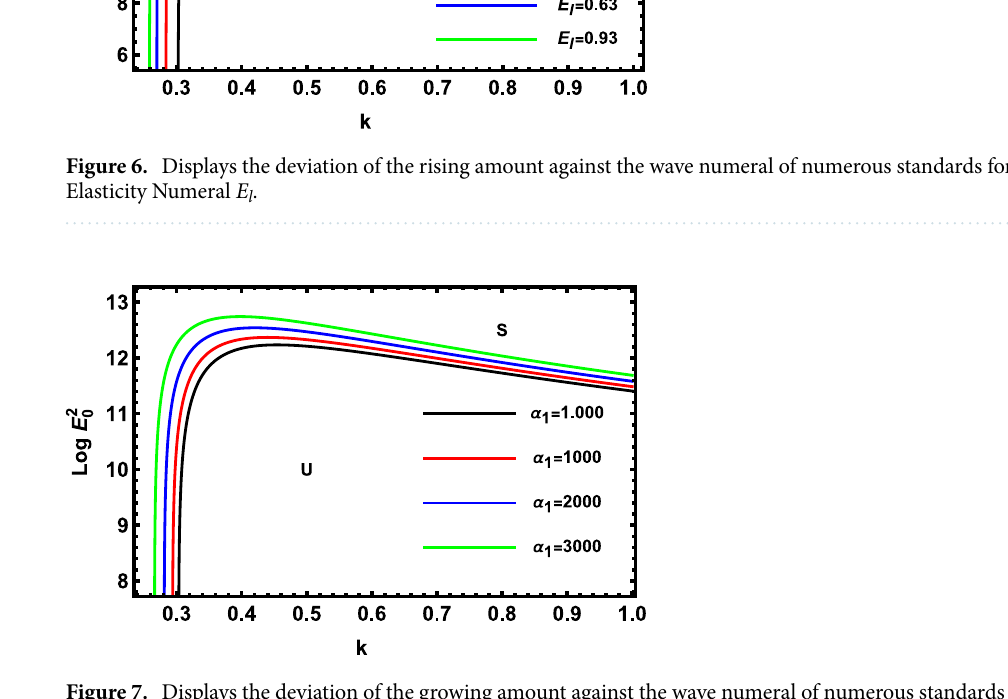
Figure 7. Displays the deviation of the growing amount against the wave numeral of numerous standards for the MHT constant α 1